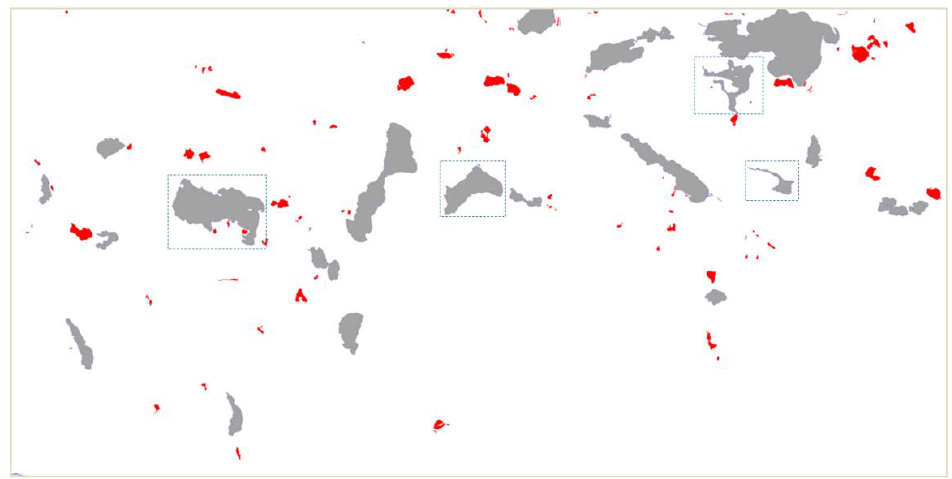
Figure 14. Overlay of the eleventh and twelfth levels.